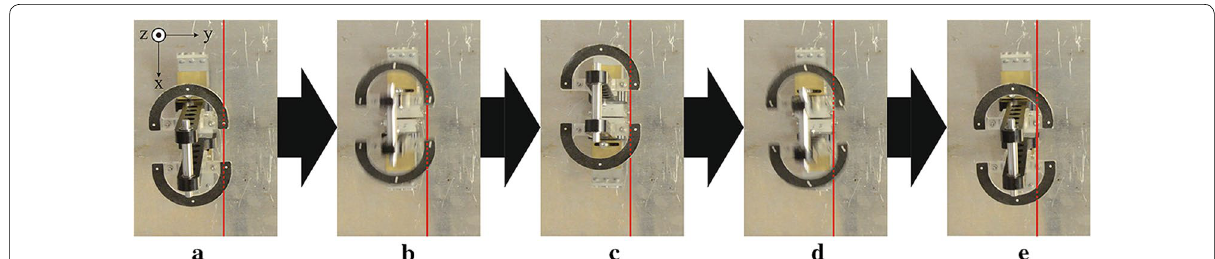
Fig. 13 Top view of the thermal walker walking on a heated horizontal surface. L t 0.21 s, c t 0.38 s, d t 0.58 s, e t 0.79 s = = = =